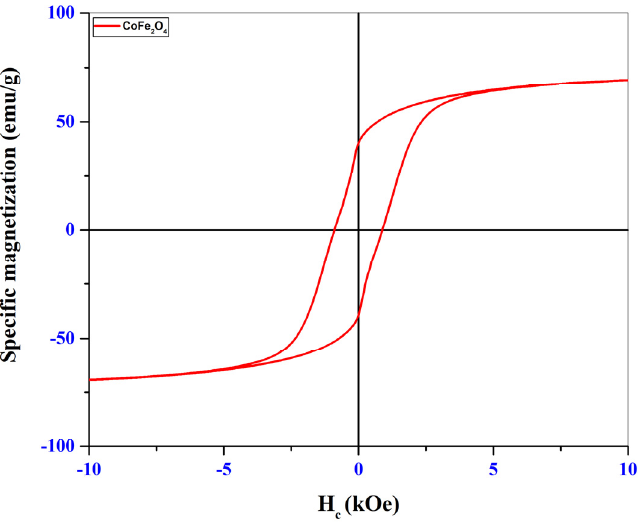
Figure 5. Magnetization of CoFe 2 O 4 sample.